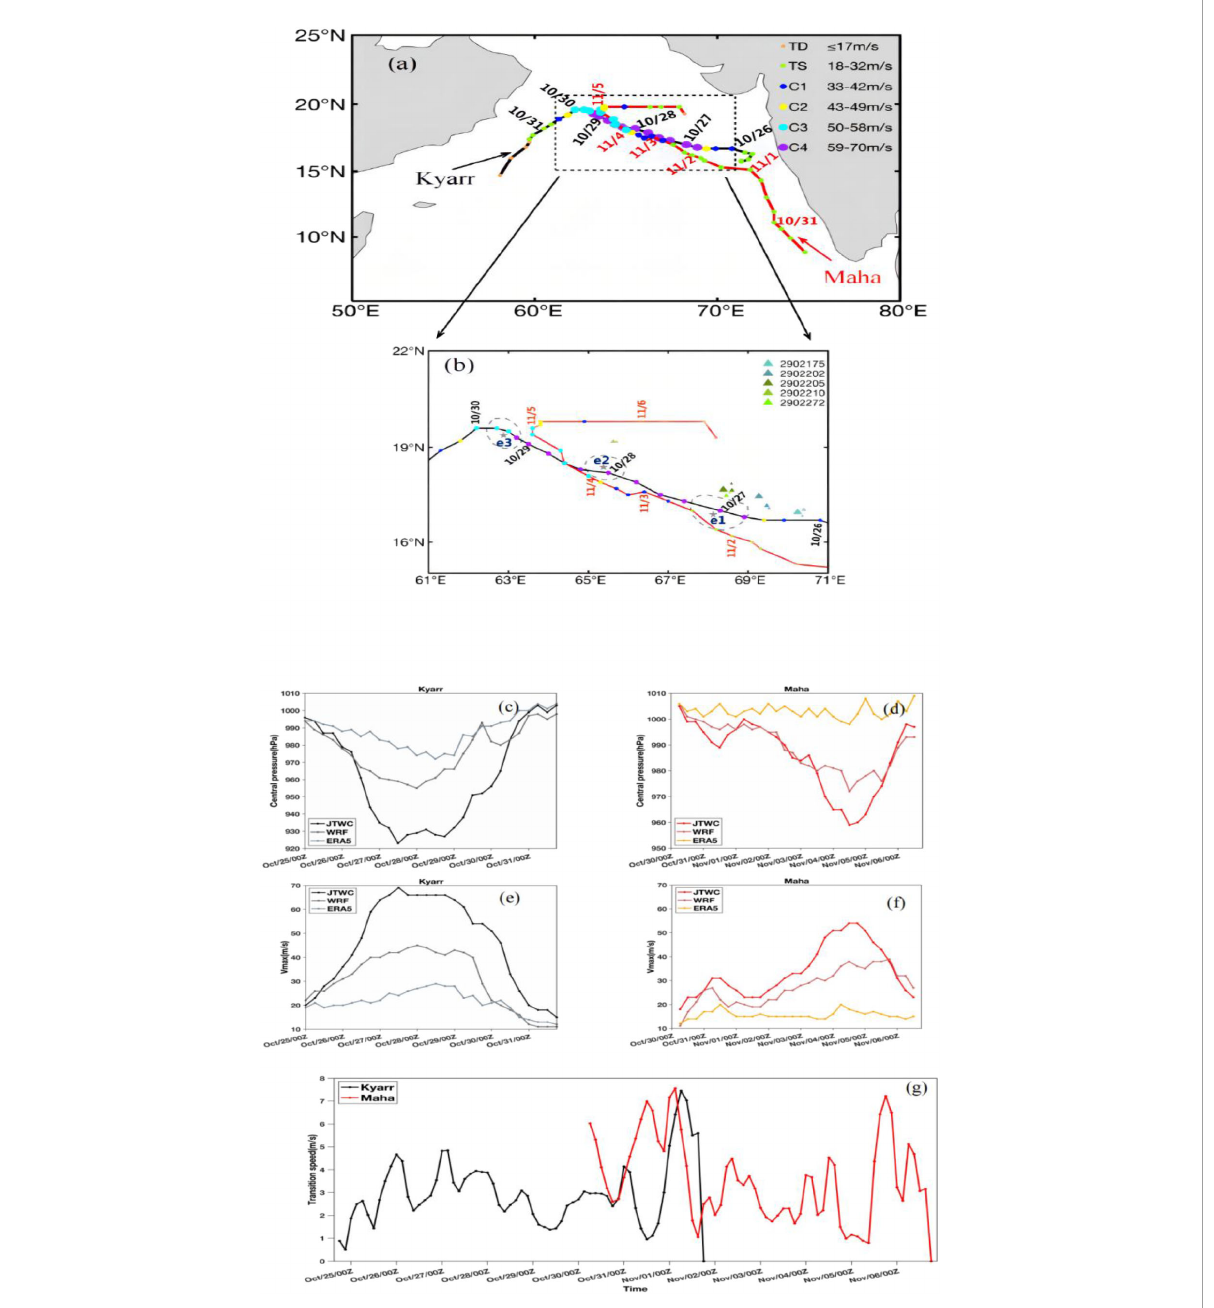
FIGURE 1 Tracks (A, B) , intensities according to JTWC, WRF model simulation, and ERA5 (C – F) and translation speeds (G) . In (A, B) , the black and red lines represent the tracks of TCs Kyarr and Maha, respectively. The colours of circles indicate the intensity of TCs (according to the Saf fi r-Simpson hurricane scale), and the interval of each circle is 6 hours. The grey dotted lines represent the eddy shapes, the grey fi ve-pointed stars represent the eddy centres of cyclonic eddies e1, e2, and e3 (November 07, 2019, by eddy detection algorithms). The temporal and spatial variations in the Argo fl oats are represented by various coloured triangle symbols. The small (large) symbols represent the location of Argo fl oats pre (post)- TC